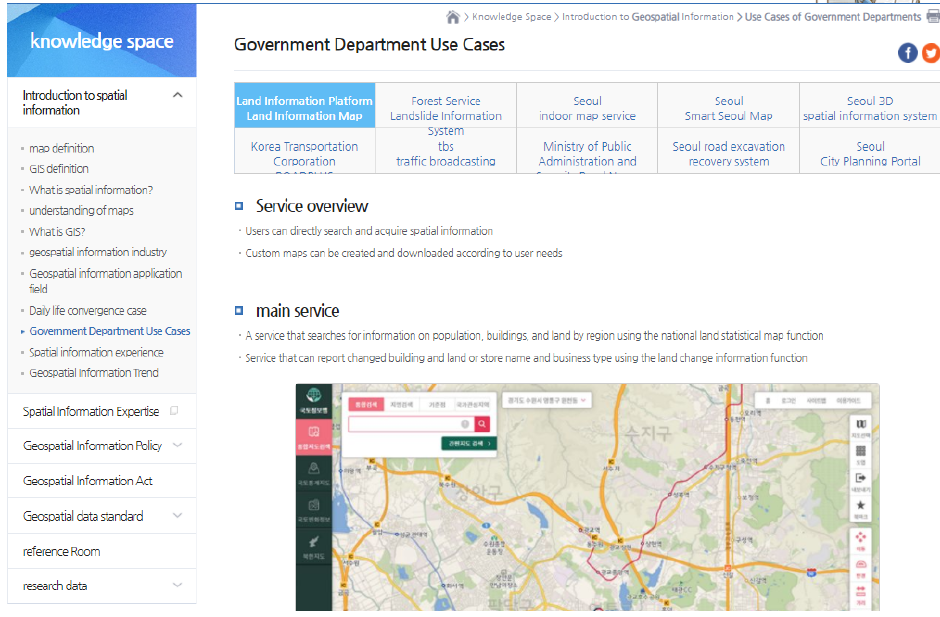
Figure 13. Use cases by hyperlinks in ‘government department use cases’.